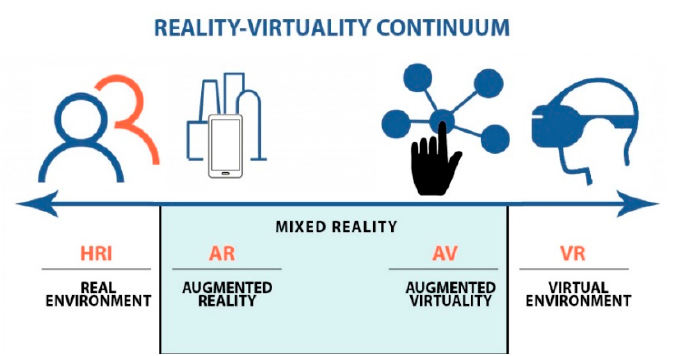
Figure 5. Reality–verticality continuum.